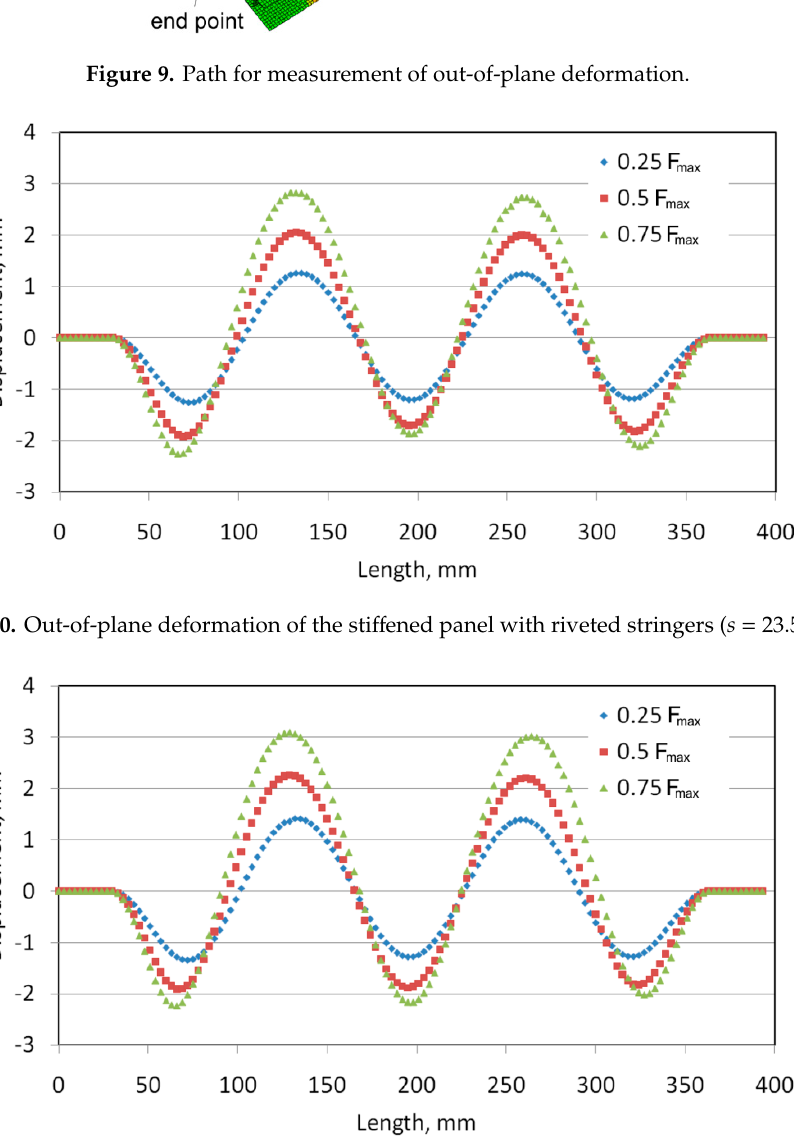
Figure 11. Out-of-plane deformation of the sti ff ened panel with welded stringers ( s = 29.5